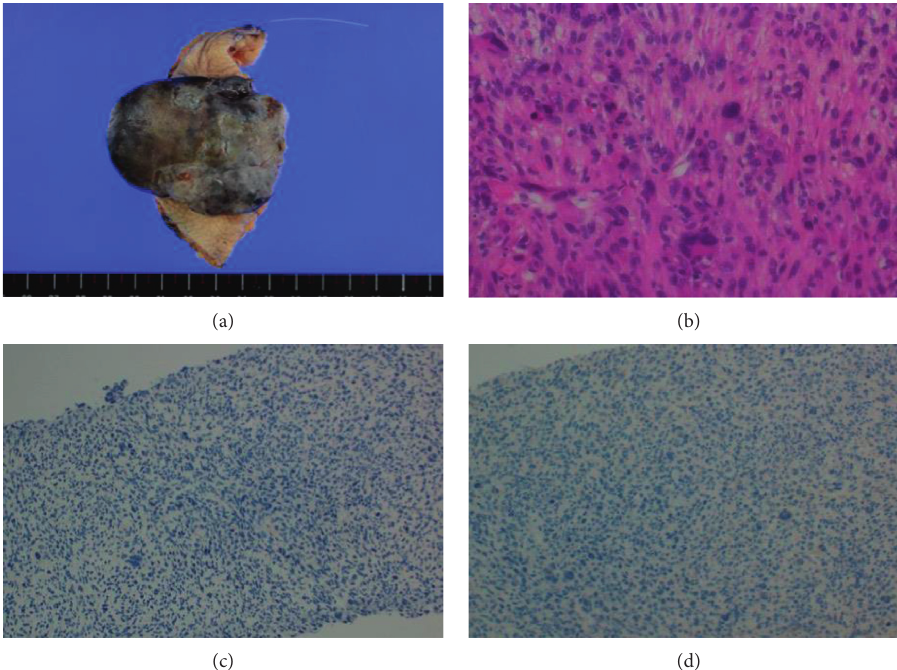
Figure 3: (a) Gross view of the resected tumor. The tumor is observed to be continuous to the keloid and measures approximately 6.2 × 6 × 3.2cm. (b) Histopathological examination following hematoxylin and eosin (HE) staining revealing short pleomorphic spindle cells and polygonal cells with a storiform pattern, accompanied by abundant mitotic activity, suggesting undifferentiated pleomorphic sarcoma. The tumor is negative for cytokeratin AE1/AE3 (c) and CAM5.2 (d) on immunohistochemical